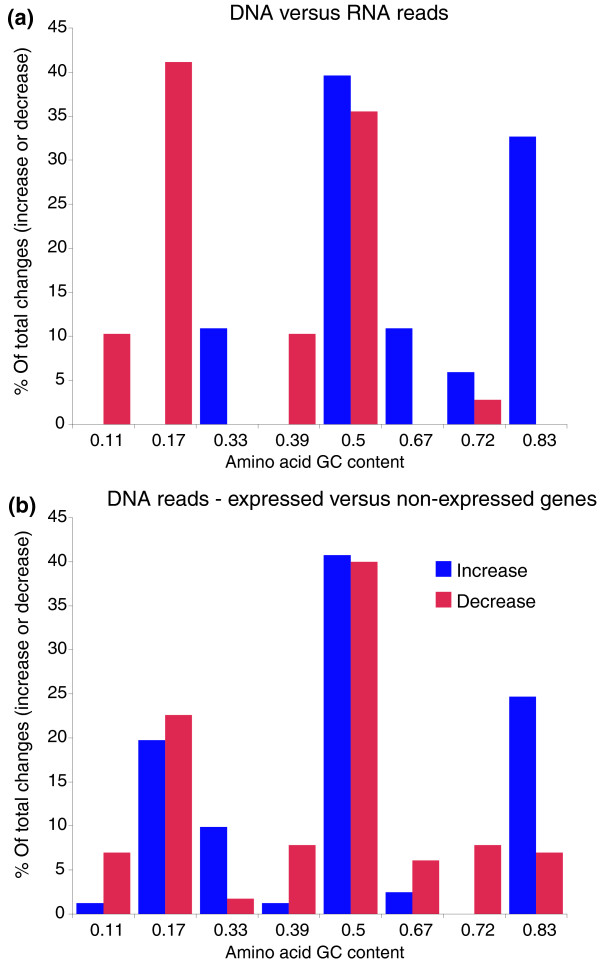
Amino acid usage changes based on GC content of synonymous codons in ocean communities. (a,b) Charts include only those amino acids whose frequency significantly increased (blue) or decreased (red) in the RNA relative to the corresponding DNA reads (a) or in the expressed genes relative to the non-expressed genes in the DNA reads only (b). Significant increases/decreases are categorized based on the GC content (x-axis) of the amino acid, where GC content = (Number of GC bases among synonymous codons)/(Number of total bases among synonymous codons). Data from all 11 DNA/RNA ocean samples are pooled; these charts exclude the soil data, in which GC enrichment in the RNA was not observed.